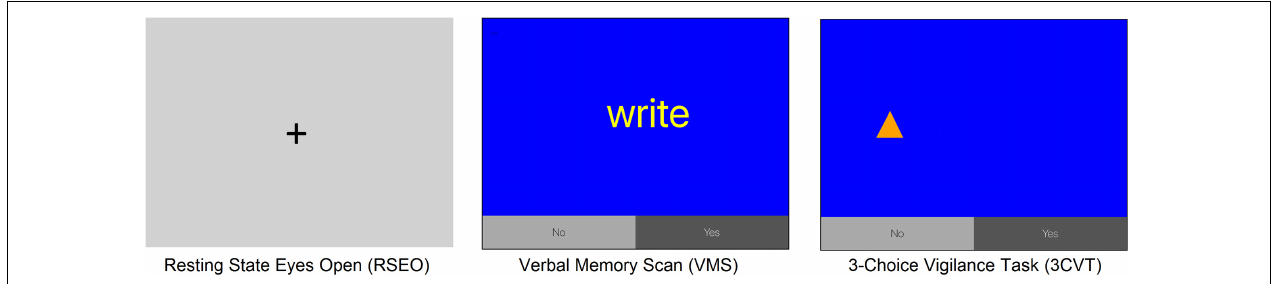
FIGURE 1 | Display screens of task interfaces for resting state, VMS, and 3CVT. Left panel: fixation cross for RSEO; middle panel: VMS; and right panel: 3CVT.